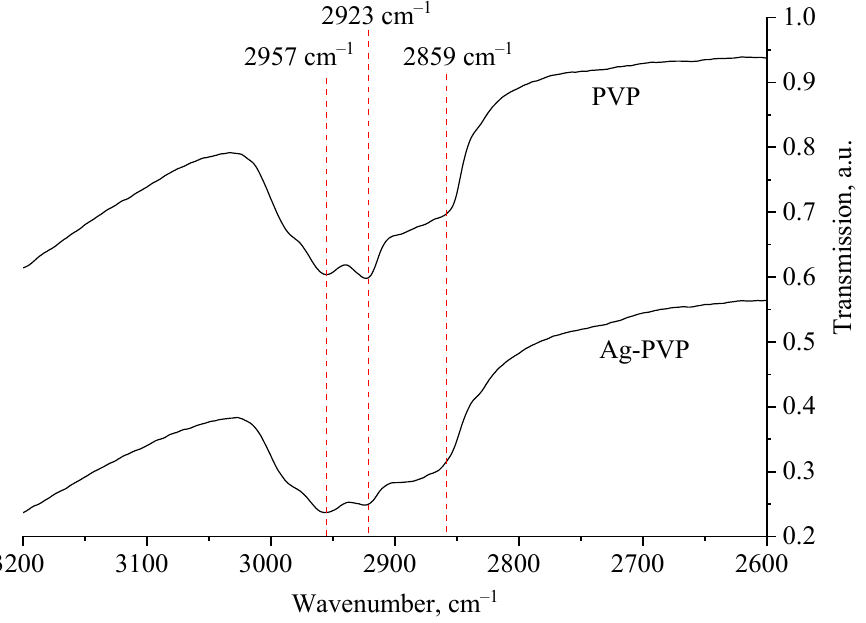
Figure 5. Section of IR transmission spectra of PVP and a preparation of Ag NPs stabilized by PVP.